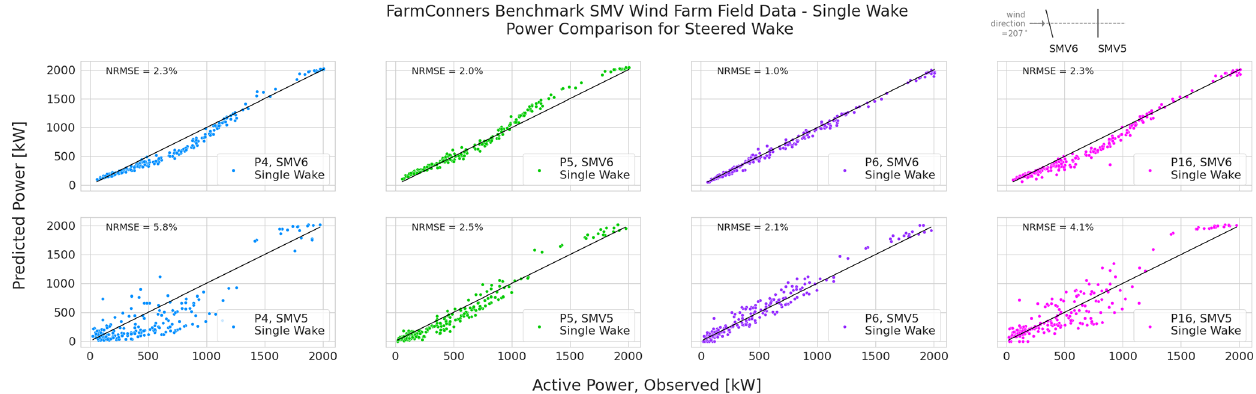
Figure 12. SMV wind farm (WF) field data, single wake under wake steering power comparison per participant. Upstream (top row) turbine power under wake steering control of − 13.3 ◦ misalignment, downstream (bottom row) turbine power under the steered wake – field observations vs. participating model predictions. Representative layout with corresponding yaw control set point is illustrated at the upper right